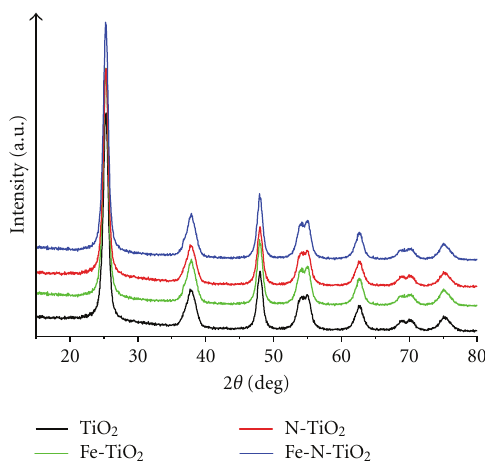
Figure 2: The XRD patterns of pure and doped TiO 2 calcined at 400 ◦